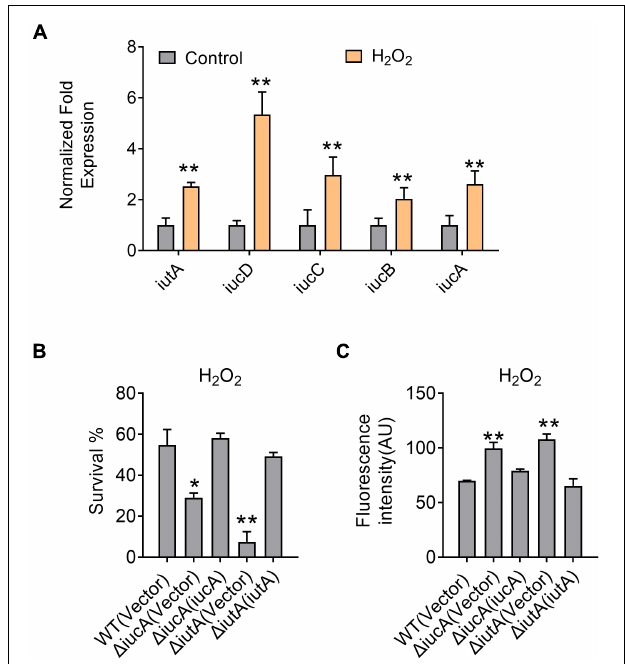
FIGURE 5 | Aerobactin-mediated iron acquisition is involved in oxidative stress resistance. (A) Aerobactin operon expression responds to oxidative stress. Y. pseudotuberculosis WT was grown to mid-exponential phase in YLB medium, then saturated bacterial cultures were diluted 100-fold in fresh M9G minimal medium with or without 5 mM H 2 O 2 , qRT-PCR analysis of the expression level of iucA , iucB , iucC , iucD and iutA . (B) Alleviation of the sensitivity of Y. pseudotuberculosis strains to H 2 O 2 . The viability of mid-exponential phase Y. pseudotuberculosis strains was determined after exposure to 1 mM H 2 O 2 for 40 min in M9G medium. (C) Deletion of iucA or iutA leads to accumulation of intracellular reactive oxygen species (ROS) under oxidative conditions. The intracellular levels of ROS were determined with the 2 (cid:48) , 7 (cid:48) -dichlorodihydro-fluorescein diacetate (H 2 DCFDA) probe after exposure of stationary phase Y. pseudotuberculosis strains to 1 mM H 2 O 2 in M9G medium. Statistical analyses for the rest of the assays were performed using unpaired two-tailed Student’s t -test. Data represent the mean ± SEM of three biological replicates, each of which was performed with three technical replicates. * p < 0.05; ** p <